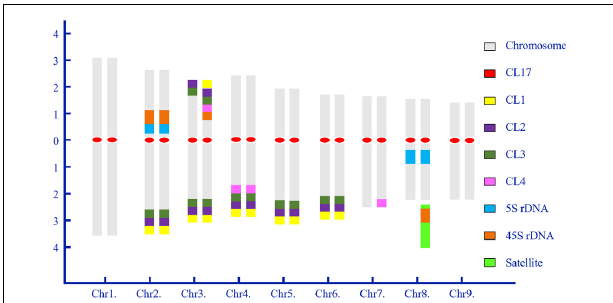
FIGURE 3 | Idiogram of diploid Carrizo Citrange rootstock showing the chromosome complement and relative positions of highly repetitive DNA sequences. Numbers on the x - and y -axis indicate the numbers of homologous chromosome pairs and the relative arm length of chromosome pairs, respectively. The ideogram is construed based on the sequential multicolor FISH-based karyotype. Chromosomes are arranged in matched, homologous pairs and ordered by the entire length from the longest to shortest and centromere positions, and a combination of these two aspects of chromosome morphology. The color scheme at right side shows the color of each probe as represented in this